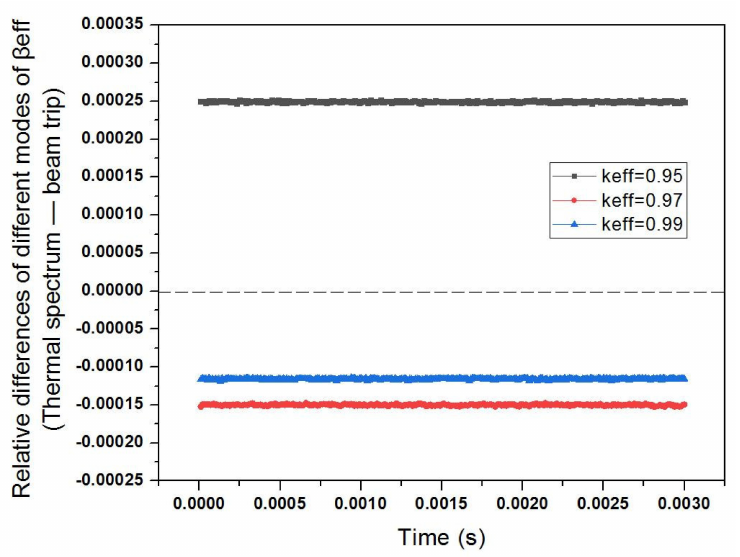
Figure 11. Relative differences in β eff with time for different modes of the thermal spectrum, under different subcriticalities and beam trips.